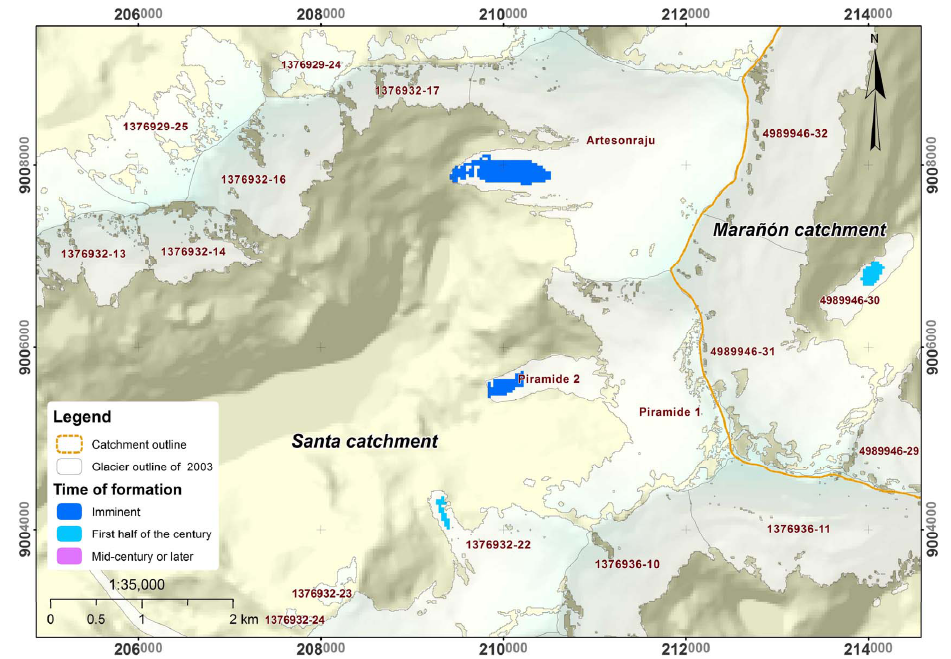
Figure 8. Time classes of possible future lake formation in the catchment of Laguna Parón, Cordillera Blanca, showing two lakes with formation imminent or underway and two lakes with probable formation during the first half of the century. The calculation was done using an acceleration scenario and extrapolated altitude changes. Glacier outlines are from [15].